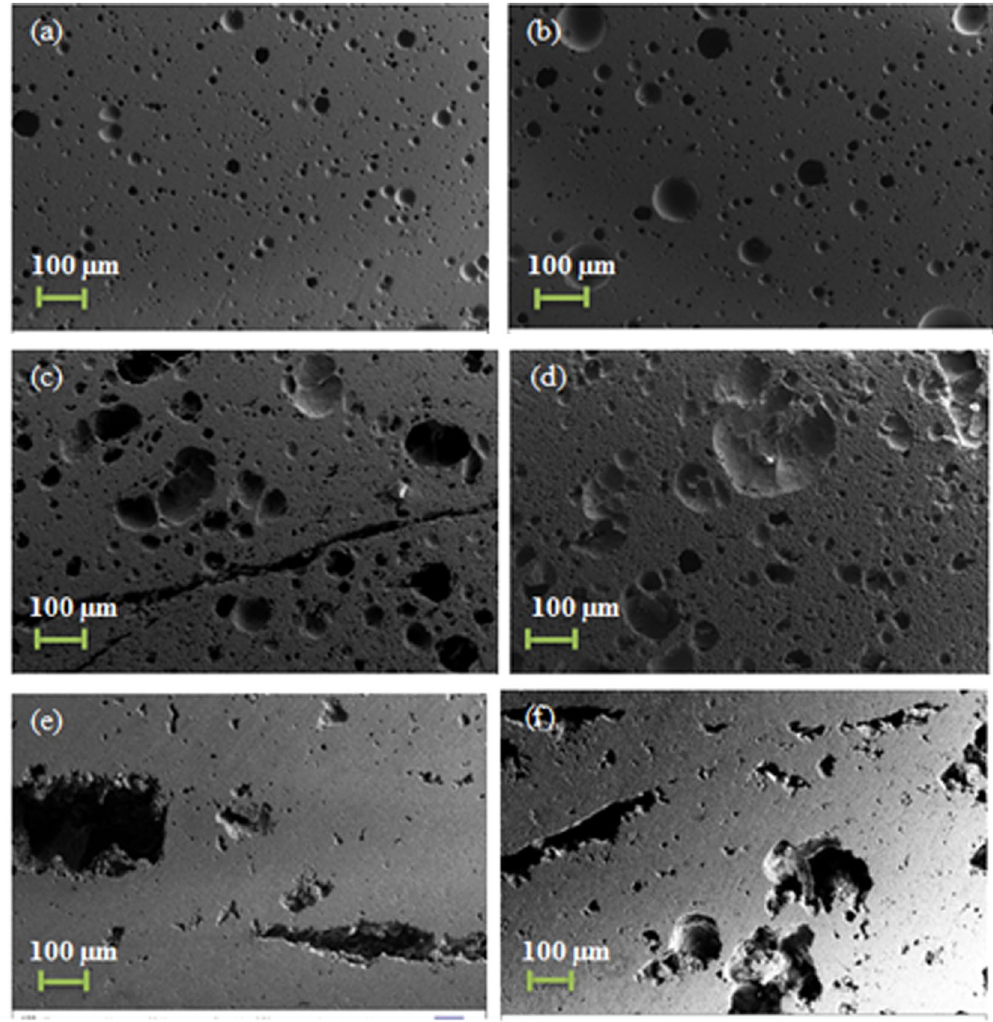
Figure 6. SEM micrographs of the cross section of samples sintered at 580 °C, 600 °C for glasses S53B50 ( a , b ), P40B10 ( c , d ) and Sr ( e , f